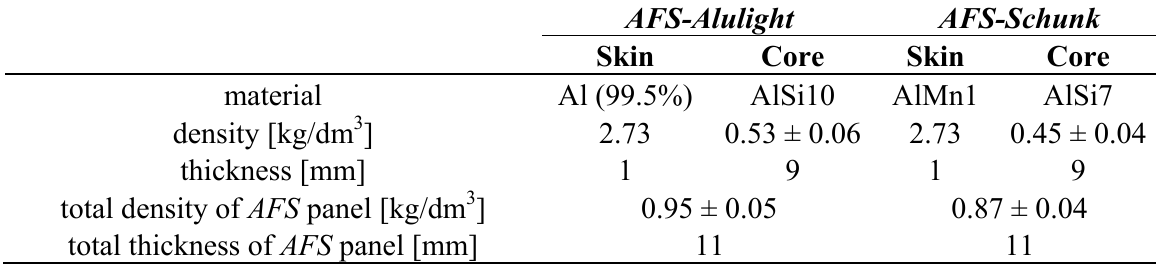
Table 2. Physical and geometrical properties of the AFS panels.